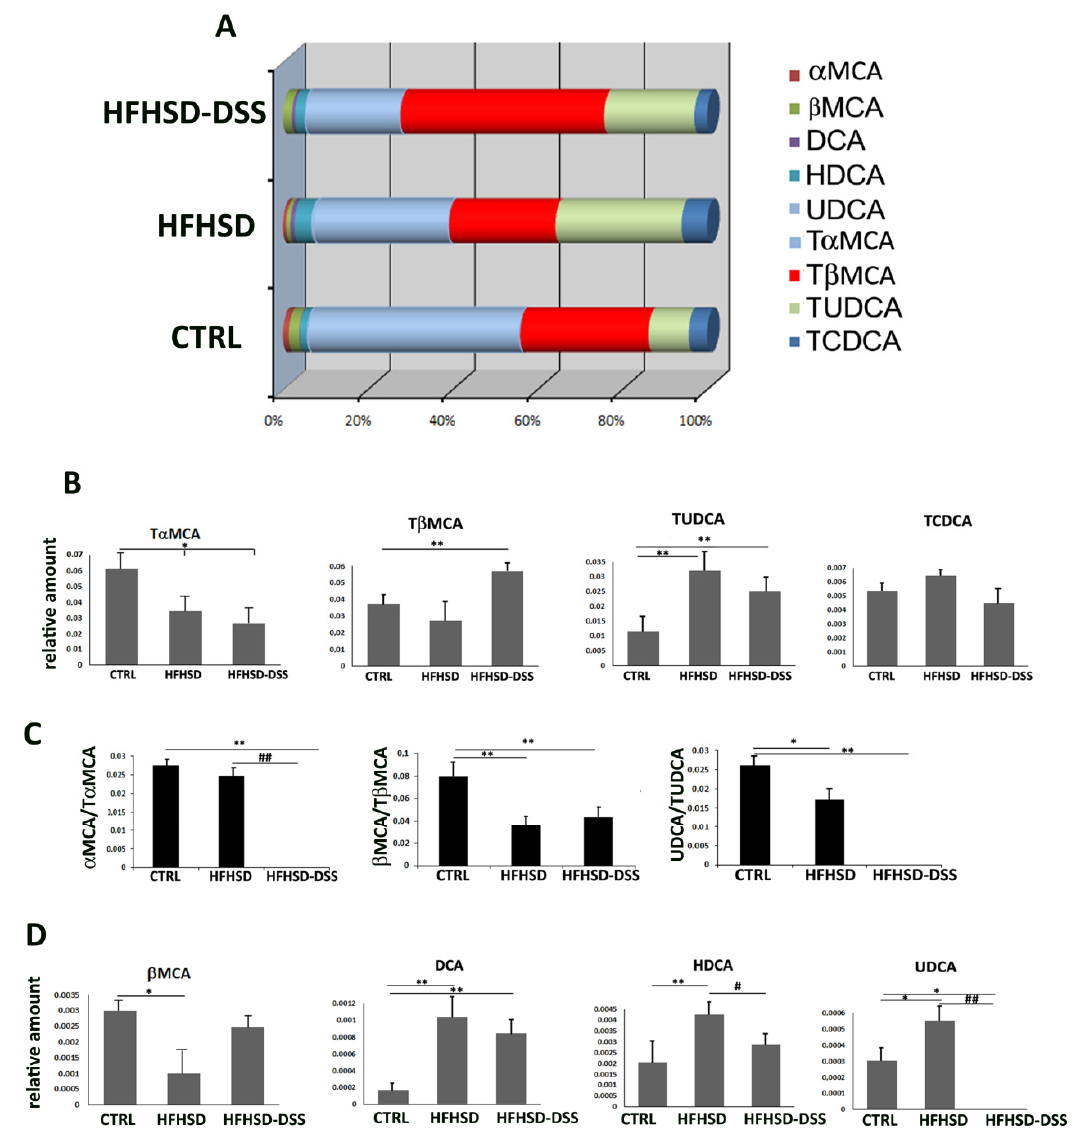
Figure 4. ( A ) Composition of principal BAs in serum of CTRL, HFHSD and HFHSD-DSS mice after 13 weeks of treatment; ( B ) Relative quantitative analysis of the most altered conjugated BAs in the three groups of mice; ( C ) Ratio between free/conjugated form of α MCA, β MCA and UDCA bile acids; ( D ) Relative quantitative analysis of the most altered unconjugated bile acids in the three groups of mice. Each value is presented as the mean ± SD for four mice. * Treated groups vs. CTRL; # = HFHSD vs. HFHSD-DSS; Statistical significance: * p < 0.05; ** p < 0.01; # p < 0.05; ## p < 0.01. 2.4. The Endotoxicity Marker LBP Is Increased in Serum of HFHSD-DSS Mice In our previous work [24], we evidenced the presence of bacterial molecules in the liver of HFHSD-DSS mice because of a leaky intestinal barrier. This finding could suggest the possibility of a systemic circulation of bacteria-derived products, which were able to reach and damage distant organs such as the brain. To verify this hypothesis, levels of LBP, a protein binding lipopolysaccharide, a major component of Gram bacteria, and a reliable serum marker of endotoxicity, was determined. Overall, data showed a strongly